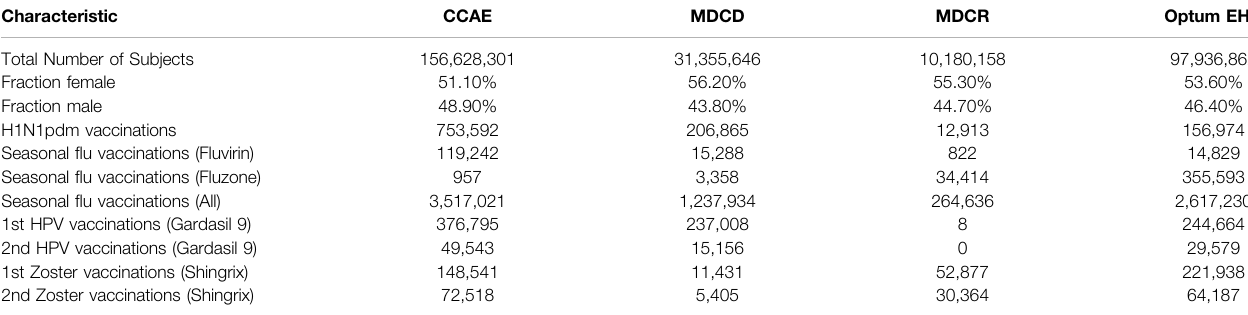
TABLE 2 | Database characteristics and vaccination counts during the vaccination study period